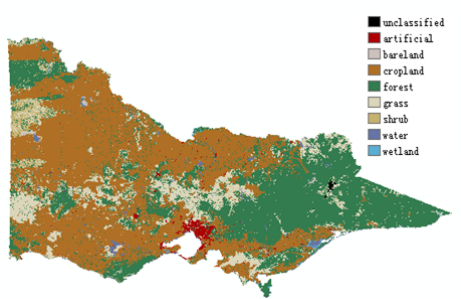
Figure 5. The classification result based on